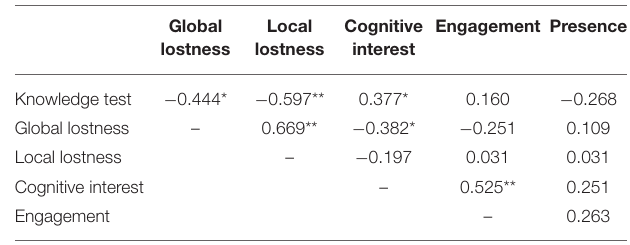
TABLE 5 | Lostness, knowledge, and in-game experience questionnaire means and standard deviations from the combined studies.